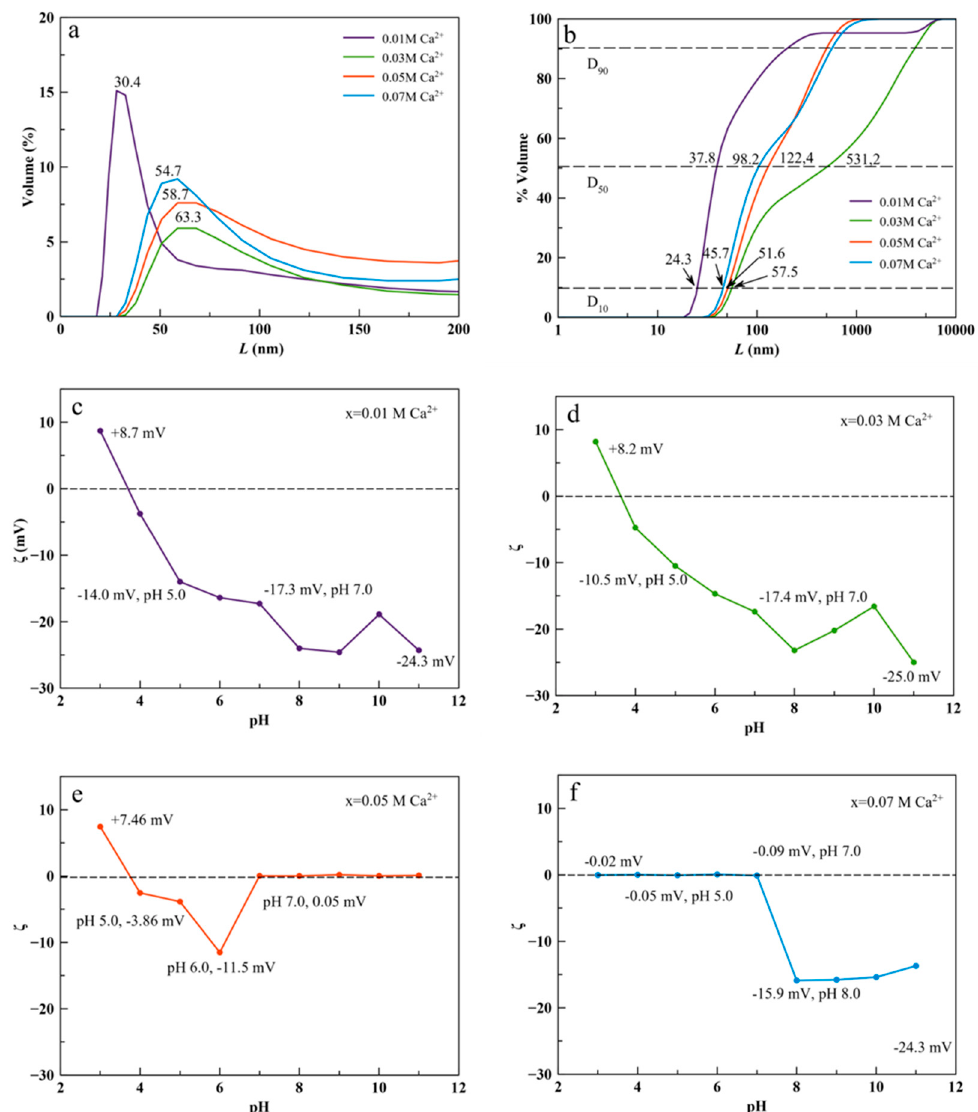
Figure 5. ( a ) Volume-based CSD and ( b ) cumulative volume-based CSD of cit-Ca 2+ :TbPO 4 ·nH 2 O nanocrystals prepared with Ca 2+ doping concentrations x = 0.01 (purple), 0.03 (green), 0.05 (red) and 0.07 M (light blue) for 96 h, measured in aqueous suspensions (pHs 8.4, 8.9, 8.3, and 7.80, respectively). ( c – f ) ζ -potential versus pH of aqueous suspensions of cit-Ca 2+ :TbPO 4 ·nH 2 O nanocrystals.